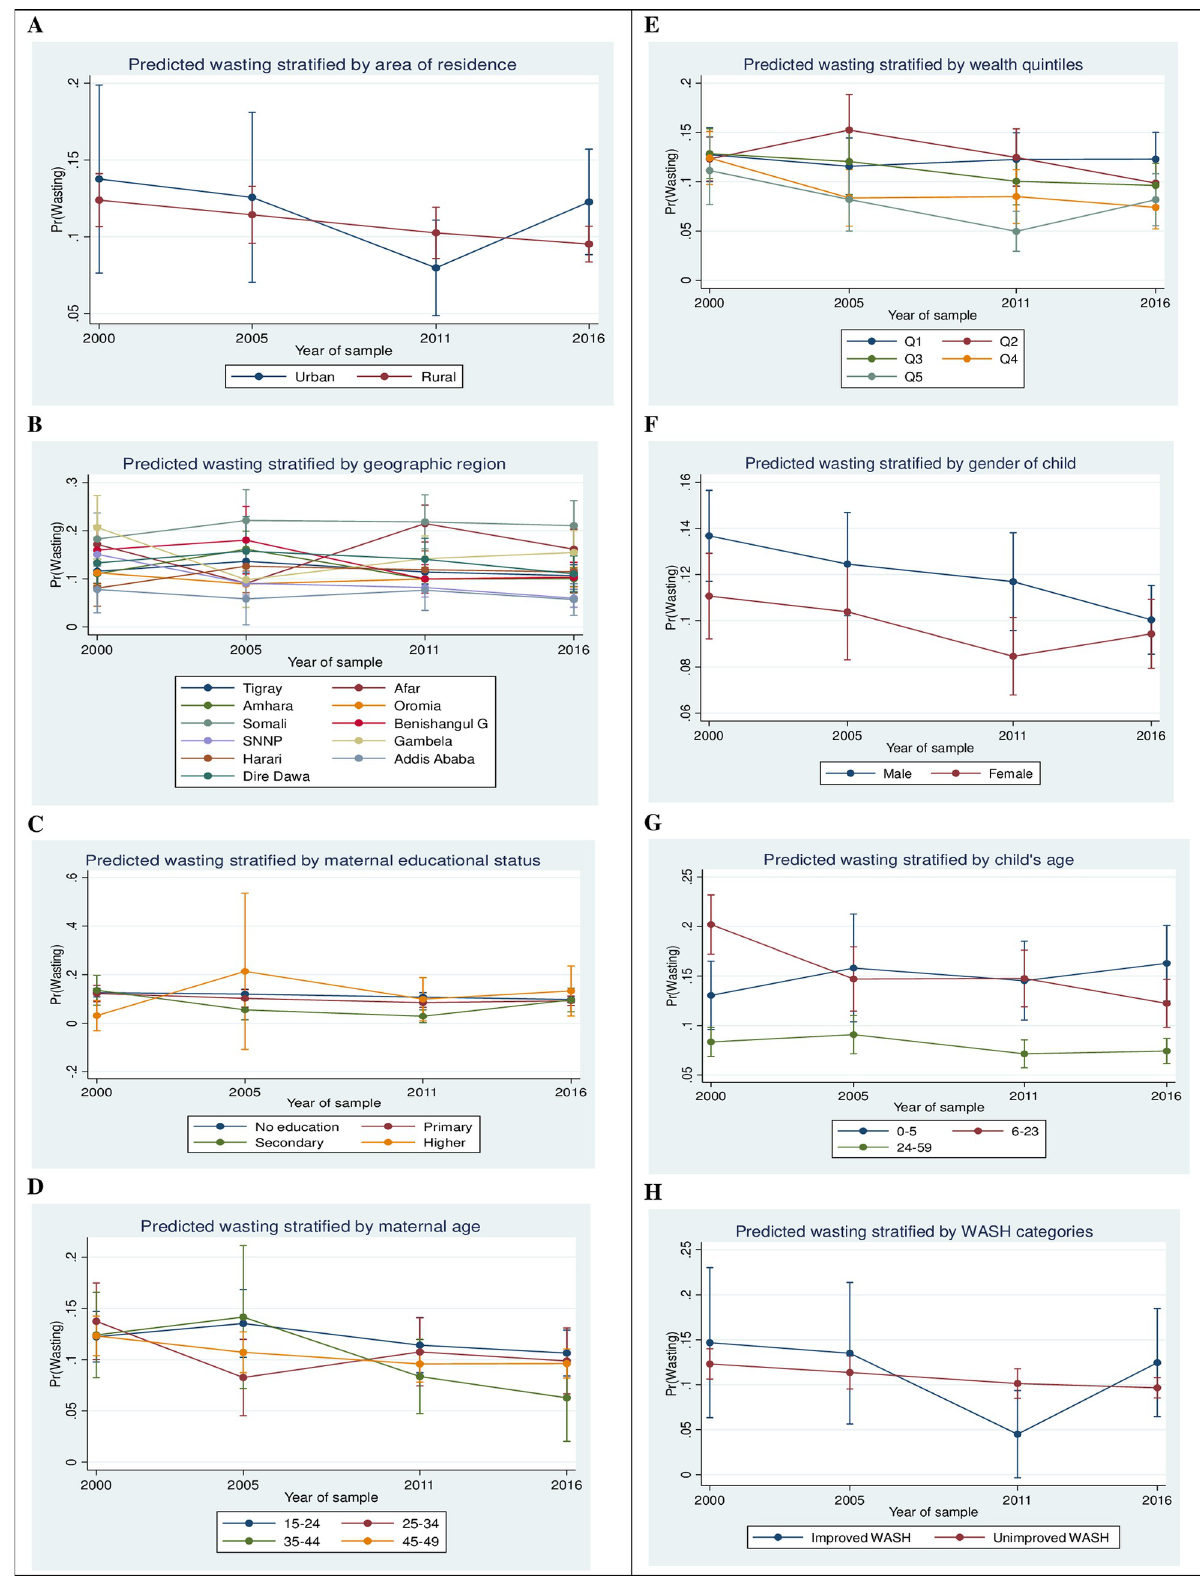
Fig 4. Adjusted predicted probabilities of wasting by key predictors among under-5 children in Ethiopia, EDHS 2000 to 2016. https://doi.org/10.1371/journal.pone.0254768.g004 PLOS ONE | https://doi.org/10.1371/journal.pone.0254768 August 5,